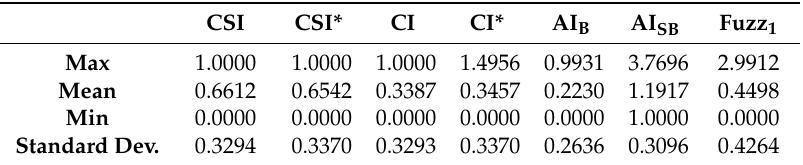
Table 2. Descriptive statistics of measures of uncertainty, fuzziness and ambiguity for the OBIA fuzzy classification result of the WV-2 scene of Munich.